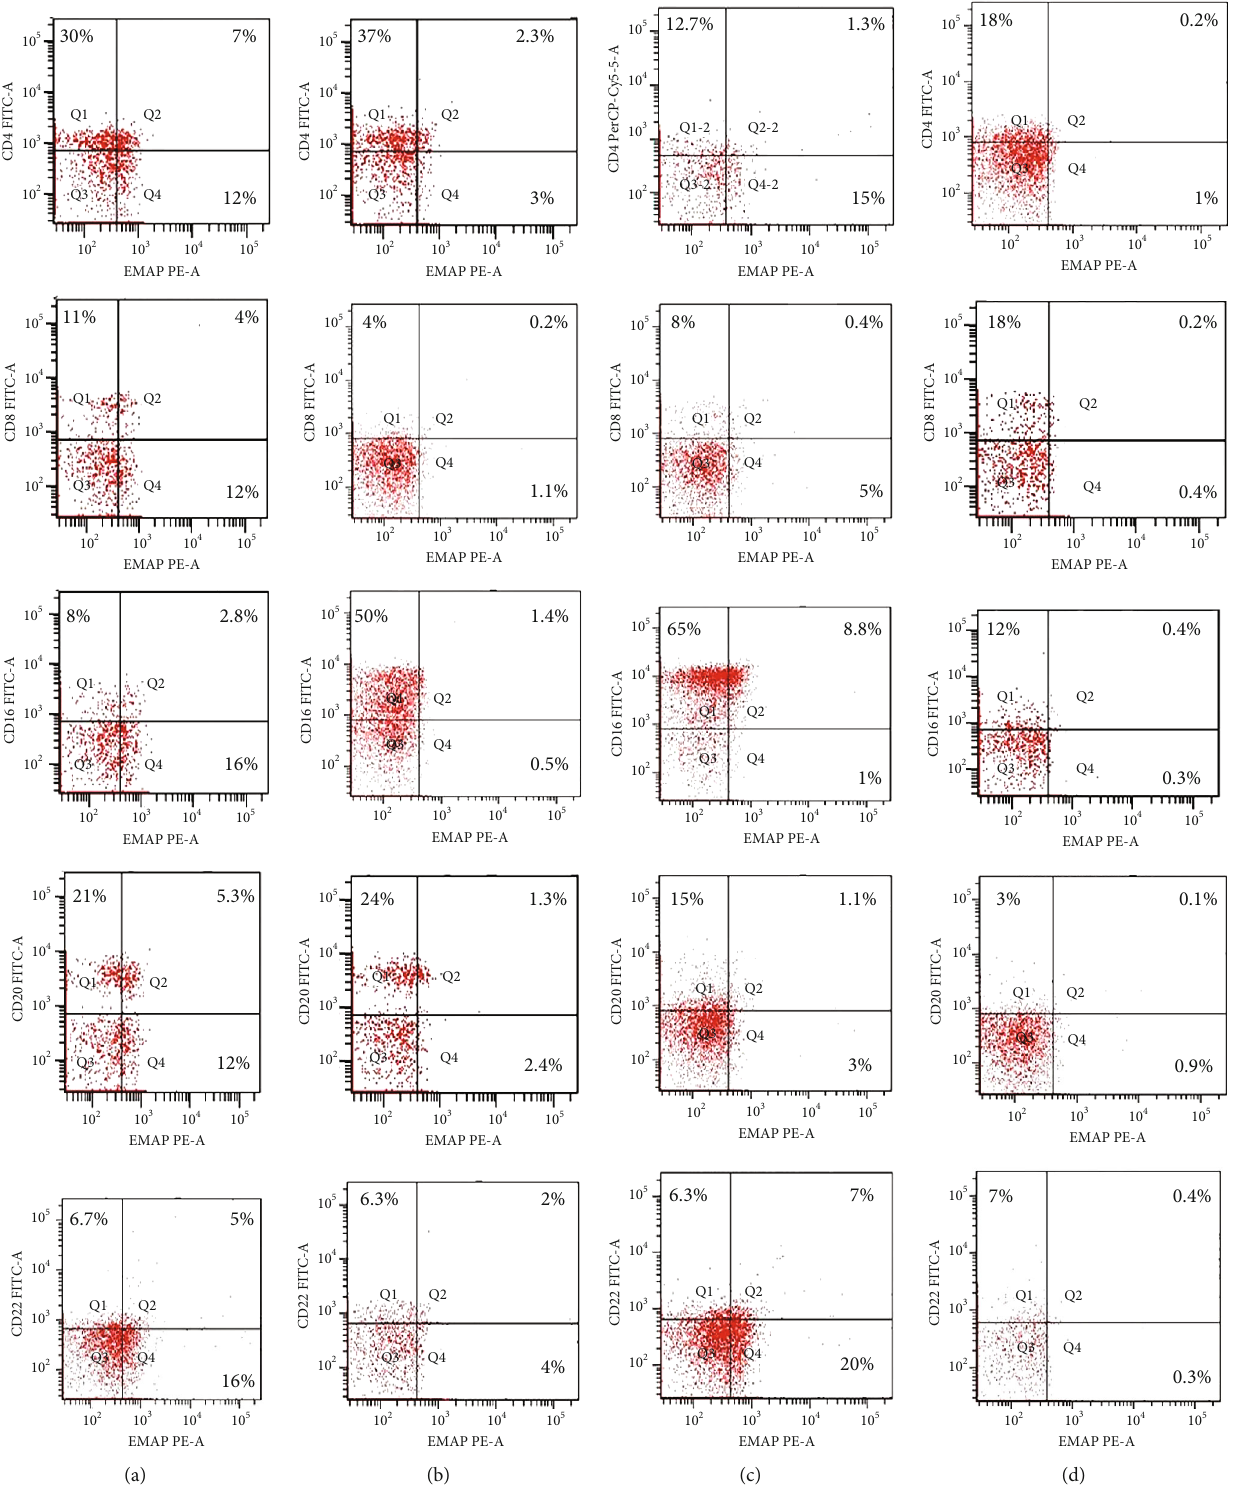
Figure 1: EMAP II is expressed on peripheral blood cells in NHL patients and normal controls. The cells were stained with FITC-labeled, PE-labeled and PerCP-Cy5.5-labeled antibodies. (a) Newly diagnosed NHL patients. (b) Patients with CR. (c) Patients with recurrence. (d) Flow cytometric dot plots of normal